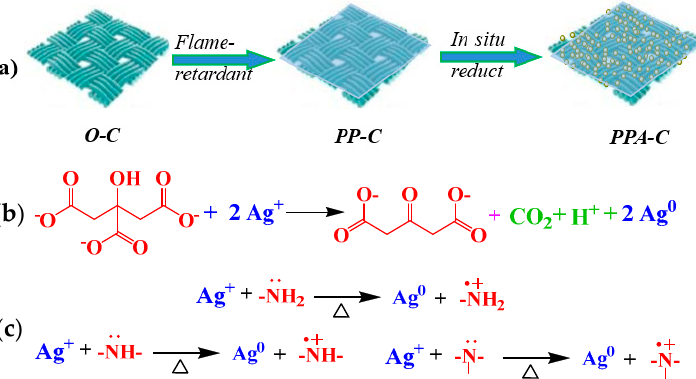
Figure 1. Schematic diagram of fabric finishing ( a ) and the reduction mechanism of sodium citrate ( b ) and amino groups in PEI molecules ( c ).